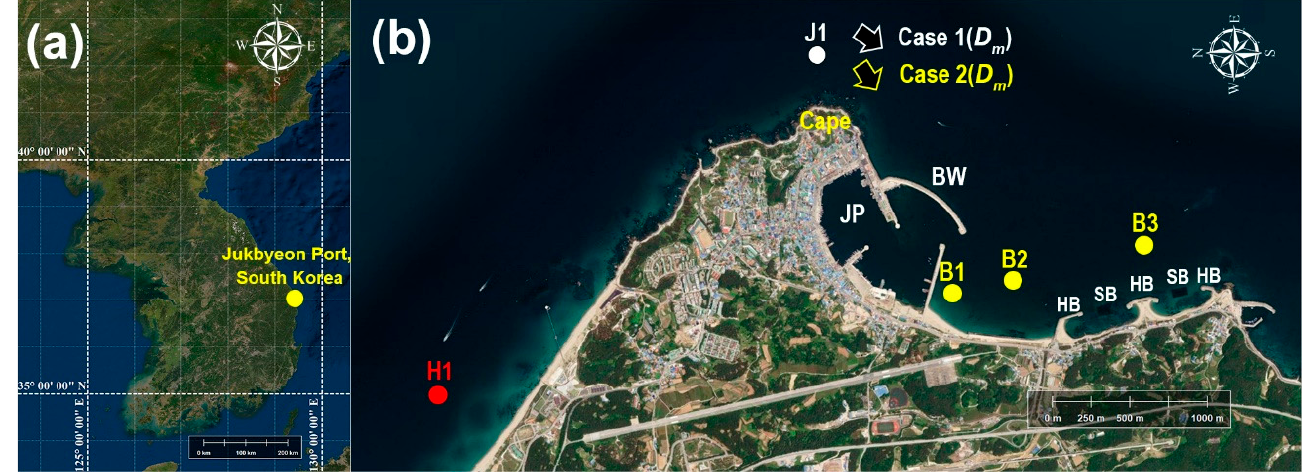
Figure 1. ( a ) Map of the Korea Peninsula and the location of Jukbyeon Port (JP); ( b ) map of JP.